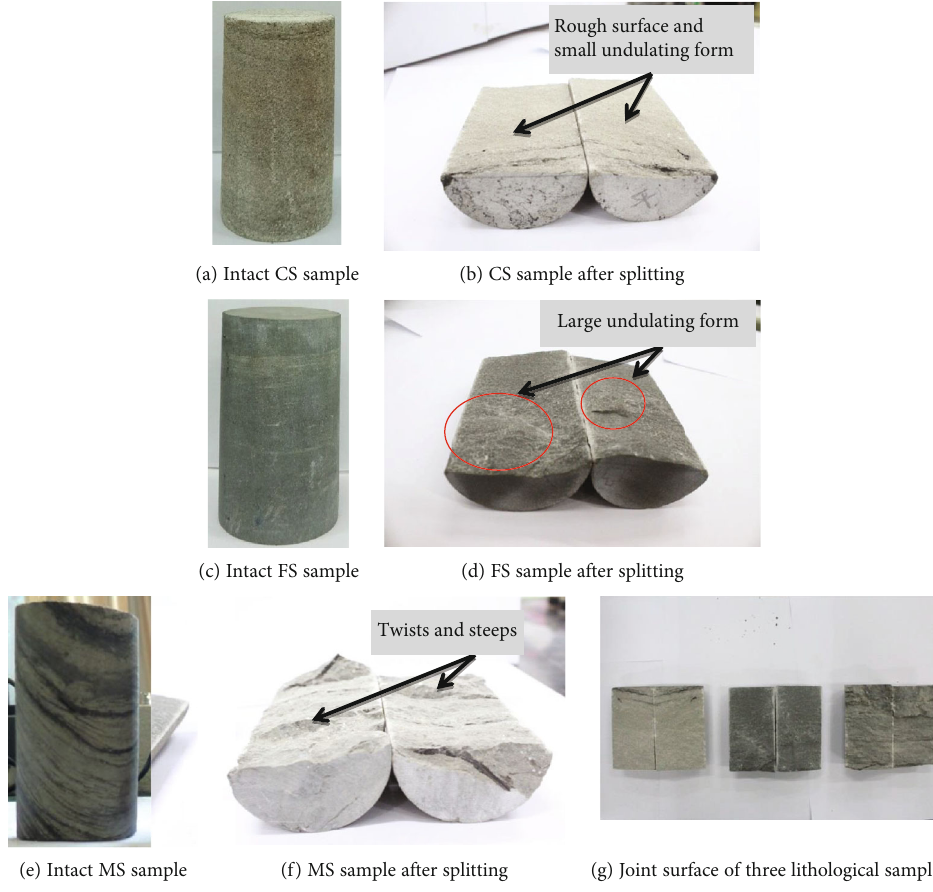
Figure 2: Joint surface of di ff erent lithological